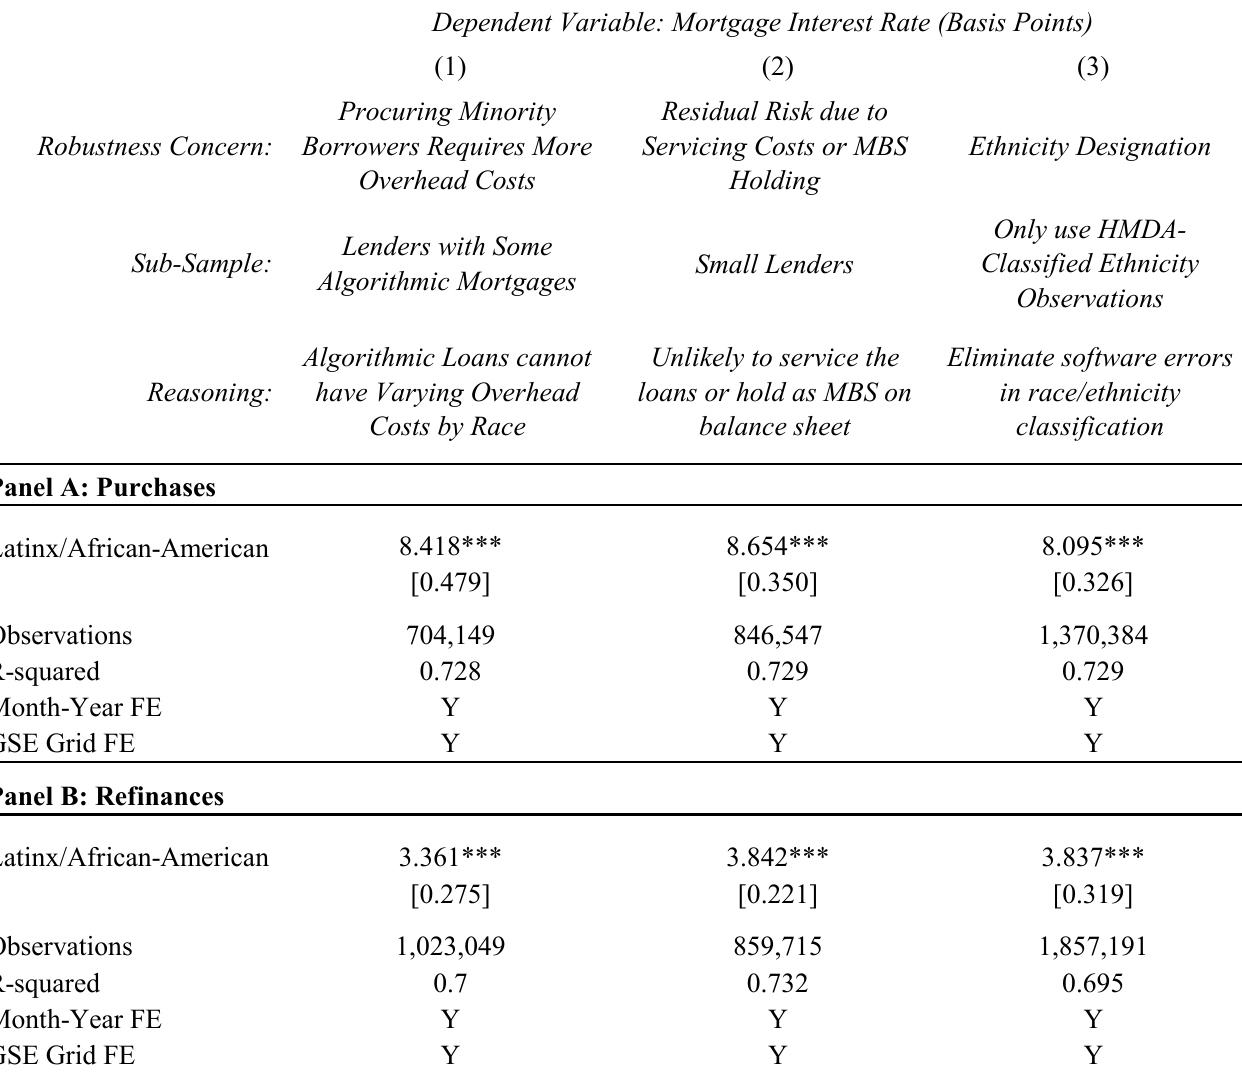
Table 5: Interest Rate Discrimination -